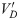
Relationship between gene actions and variance components.(a) Ideally, the variance generated by each type of gene actions is mutually exclusive therefore variance components provide a measure of relative importance of gene actions. (b) In the classical VA + VD + VI variance partition, additive genetic variance VA has contribution from all of additive, dominant, and epistatic gene actions in most circumstances. With the alternative parameterizations, all types of gene actions contribute to VD′ (c) and VAA′′ (d) in most circumstances.